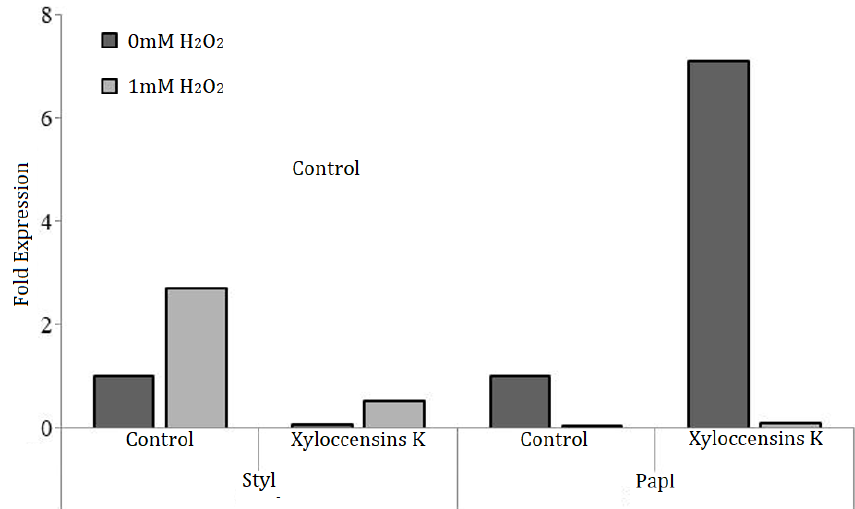
Figure 10. The effects of 25 μg, mL -1 Xyloccensins K (25 µg.mL -1 ) on the gene expression level os transcriptional factor sty1 and pap1 -investigated by using qRT-PCR analysis. Yeast re-cultured in YES medium without Xyloccensins K addition was used as control. The level of gene expression sty1 and pap1 were normalized using reference gene